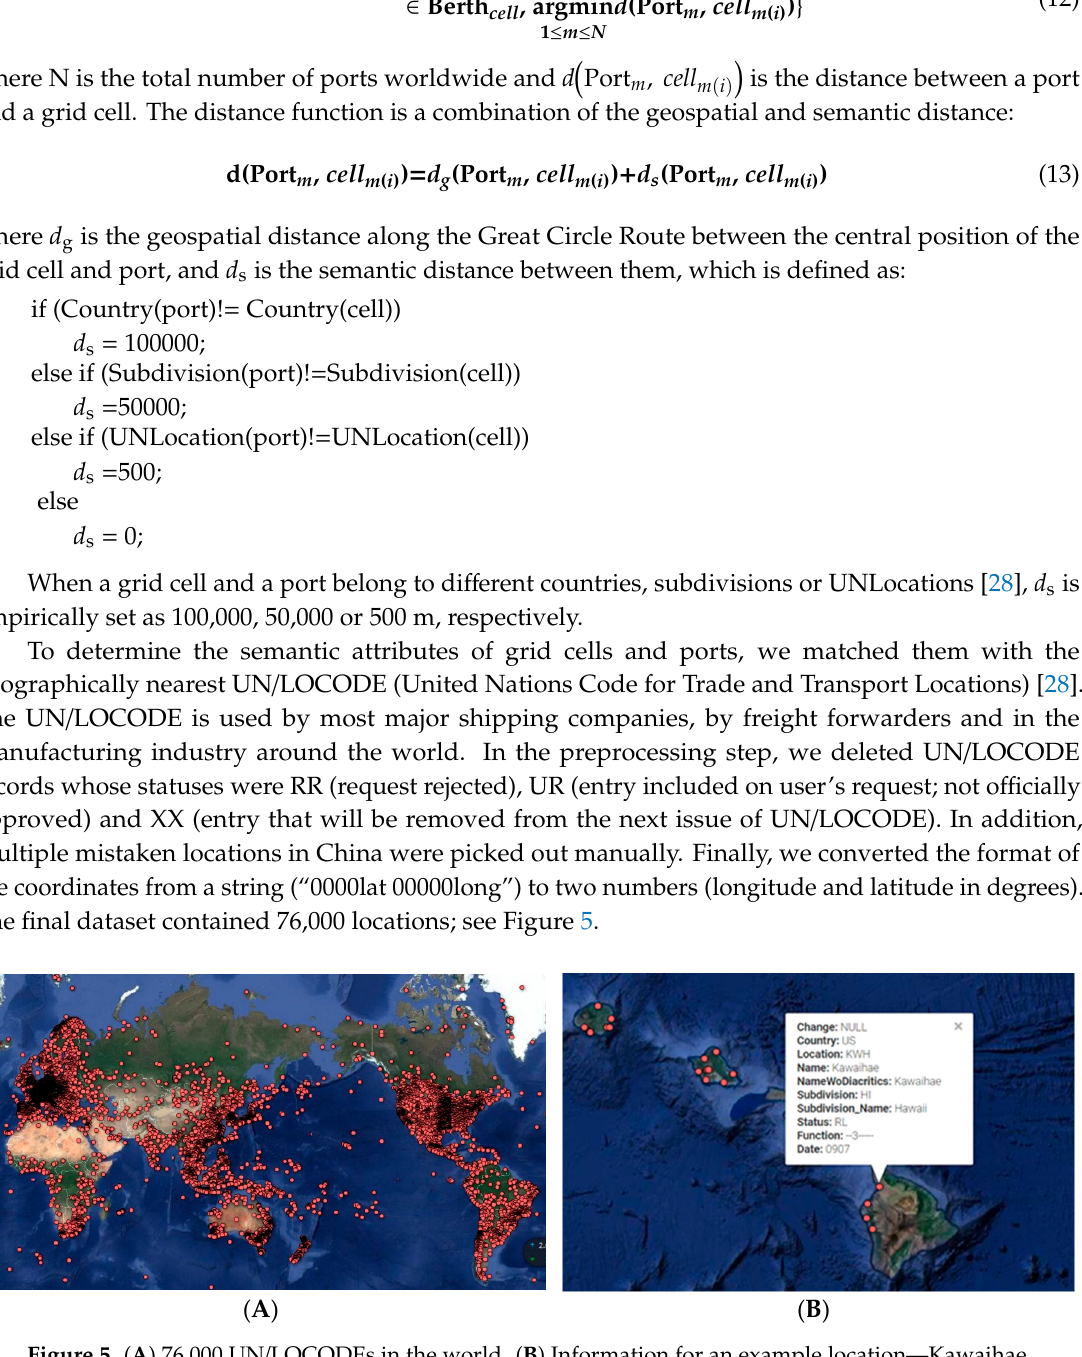
Figure 5. ( A ) 76,000 UN/LOCODEs in the world. ( B ) Information for an example location—Kawaihae in Hawaii,